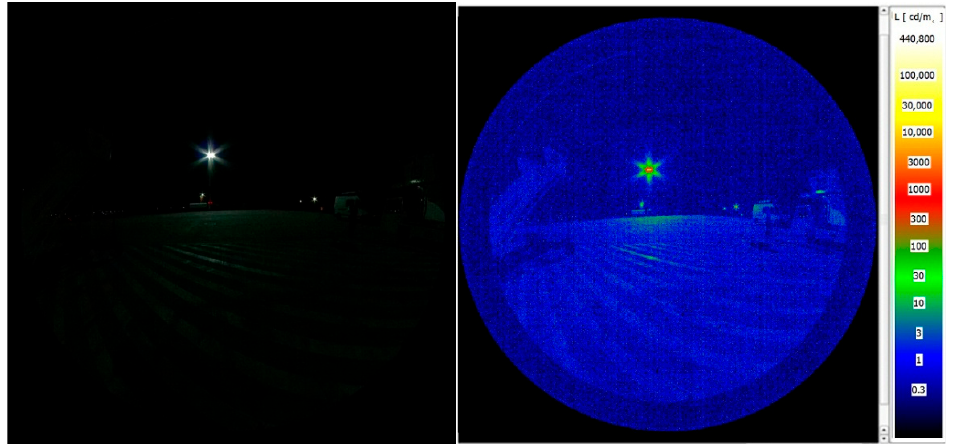
Figure 2. The view from the measurement point with corresponding luminance map. Measured GR = 51, subjective sensation of glare: just admissible, task of activity [5]: aircraft maintenance stands, GR MAX from standard [5] = 45.